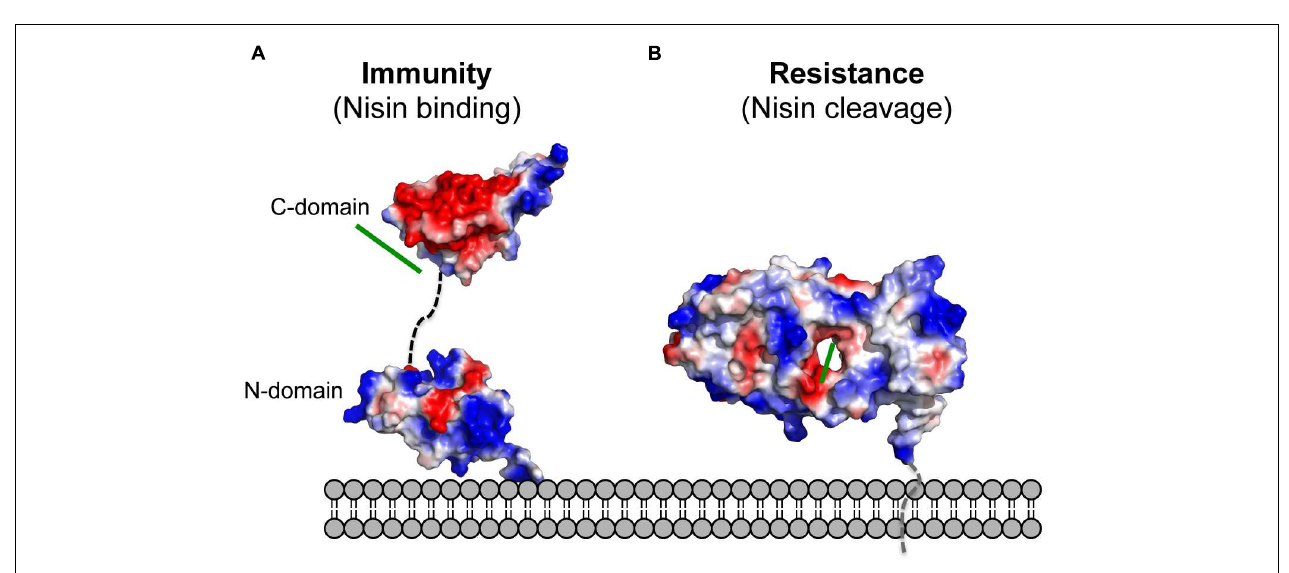
FIGURE 4 | Electrostatic surface potential of the structures of NisI and Sa NSR. The electrostatic surface potential of (A) NisI (PDB codes: 2N32 and 2N2E) and (B) Sa NSR (PDB code: 4Y68) structures is shown. Negatively charged surface areas are colored in red, while the positively charged areas colored in blue and white areas correspond to hydrophobic surfaces. The determined nisin binding site for both proteins are highlighted with a green line. The figure was created with Pymol.